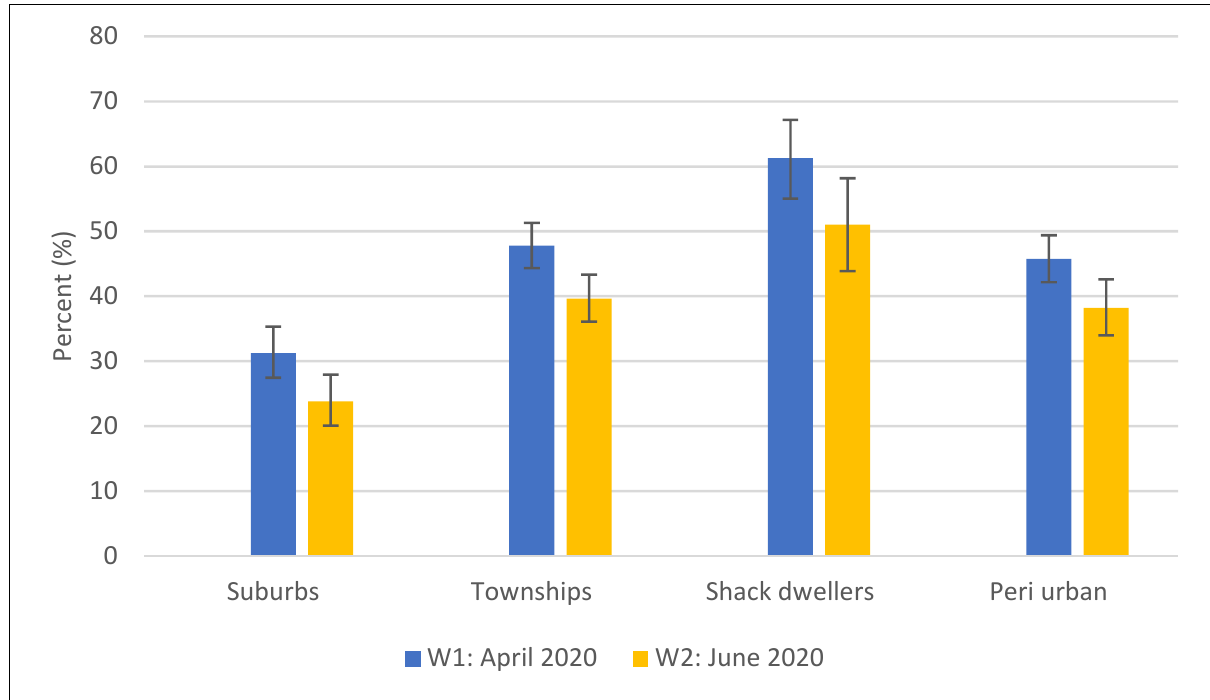
Sources: NIDS-CRAM W1 2 and W2 6 .